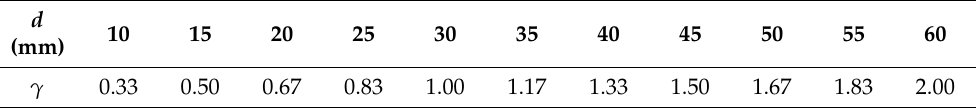
Table 2. Correspondence between γ and d